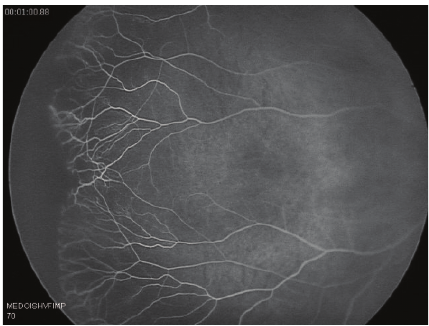
Figure 1: Fluorescein angiogram of the right eye at 1 minute reveal- ing peripheral nonperfusion.